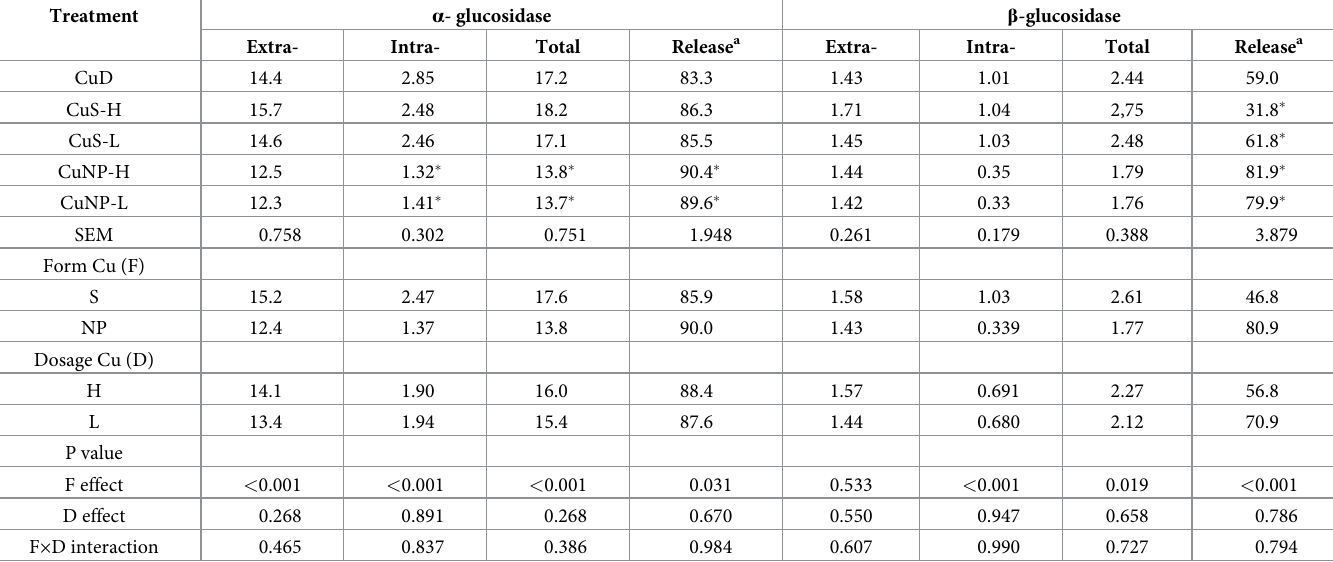
Table 6. Activity of microbial enzymes in caecal digesta of rats (μmol/h/g fresh caecal digesta). Treatment α - glucosidase β -glucosidase Extra- Intra- Total Release a Extra- Intra- Total Release a